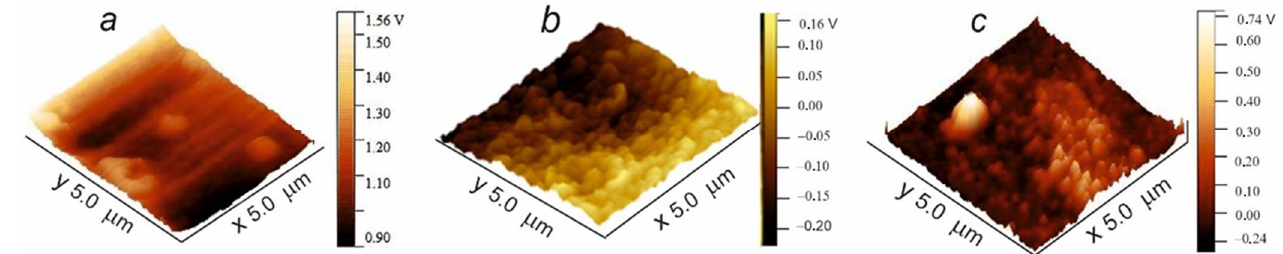
Figure 8. AFM surface potential map of uncoated TiNi substrate ( a ), coatings synthesized in argon ( b ) and nitrogen ( c ).